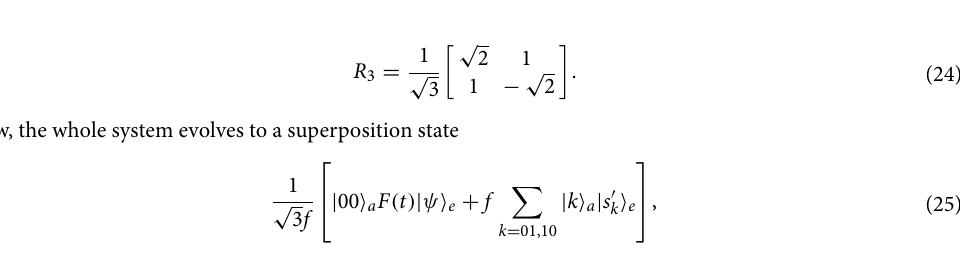
Figure 6. Quantum circuit using two qubits. The system consists of an ancillary and a work qubits, and the whole system is initialized to a state R ψ . First, a single-qubit rotation U is applied to the ancillary qubit to assign the two UE-parameters. Then, two controlled operations generate the two UE-terms. Third, a Hadamard superposes the UE-terms. Finally, the work qubit e will be operated by F ( t ), if the ancillary qubit is measured in